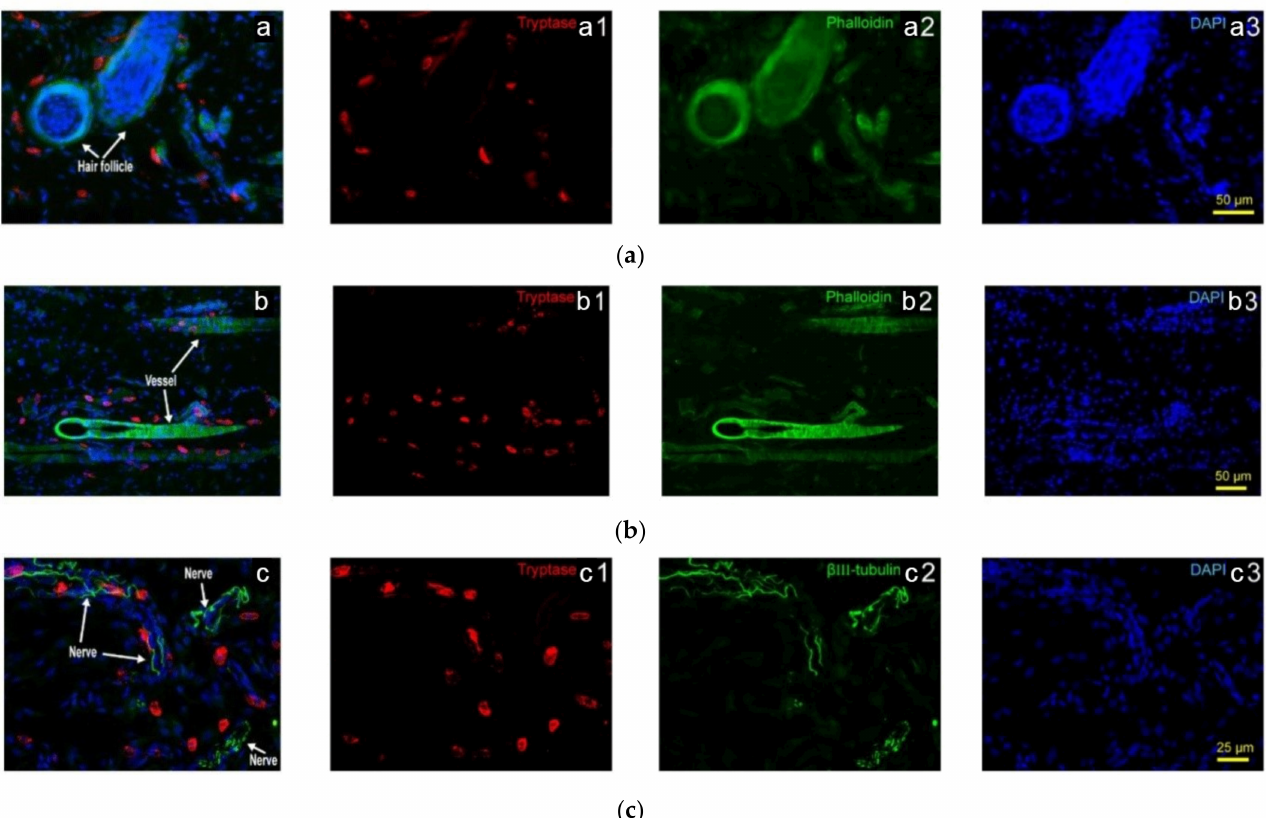
Figure 2. Subcutaneous MC distribution along hair follicles, vessels and nerve fibers of rats. ( a ) Correlation of MCs and hair follicles in skin examined with immunofluorescence histochem- ical staining with (a1) tryptase (red), (a2) phalloidin (green) and (a3) DAPI (blue). ( b ) Correlation of MCs and vessels in skin samples examined with immunofluorescence histochemical staining with (b1) tryptase (red), (b2) phalloidin (green) and (b3) DAPI (blue). Hair follicles and vessels are distinguished by their location and morphological characteristics. ( c ) Correlation of MCs and hair follicles in skin examined with immunofluorescence histochemical staining with (c1) tryptase (red), (c2) β -III tubulin (green) and (c3) DAPI (blue). Scale bars are shown in the DAPI-stained figure in each group. Based on Yang et al. (2018), [20], with permission from Ivyspring International